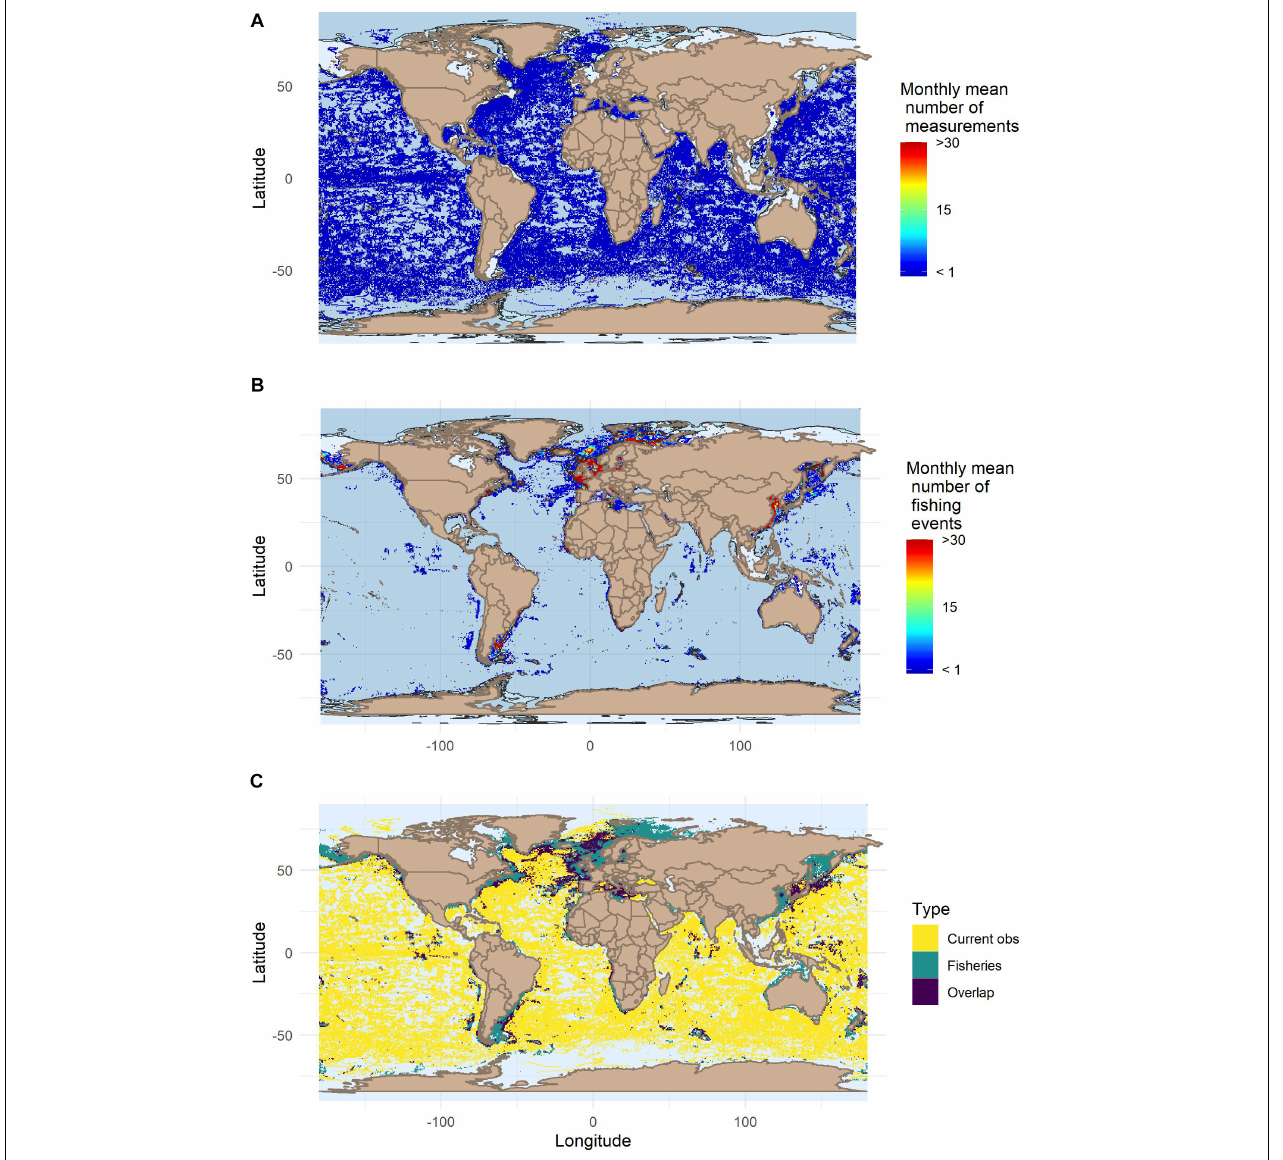
FIGURE 9 | (A) Mean monthly number of sub-surface observations for the Global Ocean. (B) Mean monthly number of fishing events for judged suitable for potential data collection. (C) Distribution of both fishing events and ocean observations, with overlap between the two plotted in purple.